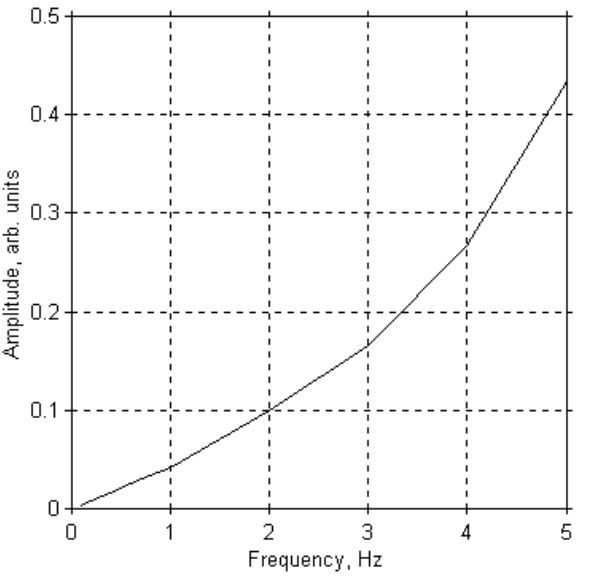
Fig. 1. The amplitude-frequency response of the induction magne- tometer in LOZ.